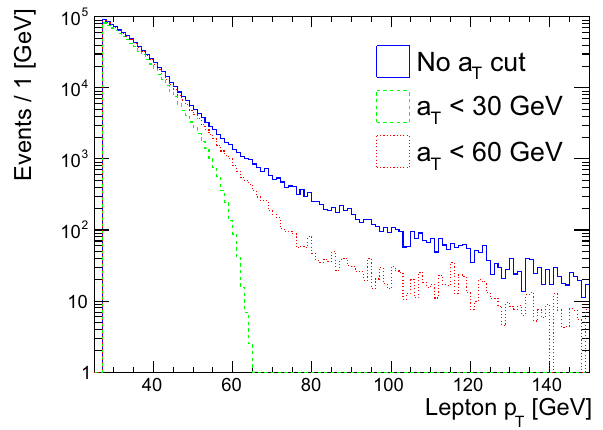
Fig. 7 Distributions of lepton p T in the selected Z /γ ∗ → ττ candi- date event samples. Three different cuts on a T are applied